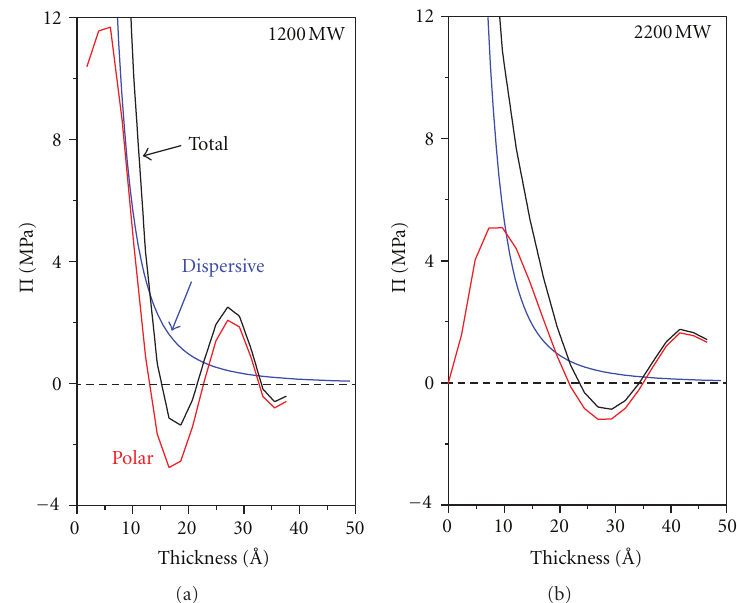
Figure 5: Surface energy-derived disjoining pressure ( Π ) as a function of Z-Tetraol film thickness.